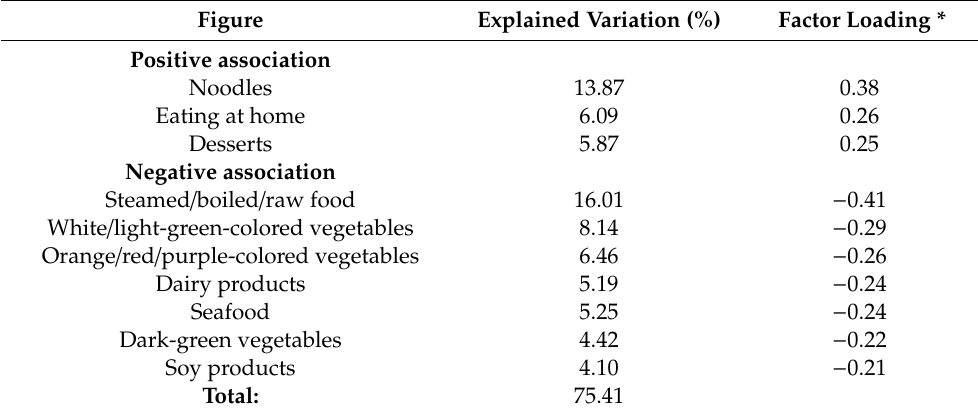
Table 3. Food groups that were strongly associated with the soluble CD163-related dietary pattern scores identified by the reduced rank regression (RRR). Figure Explained Variation (%) Factor Loading *